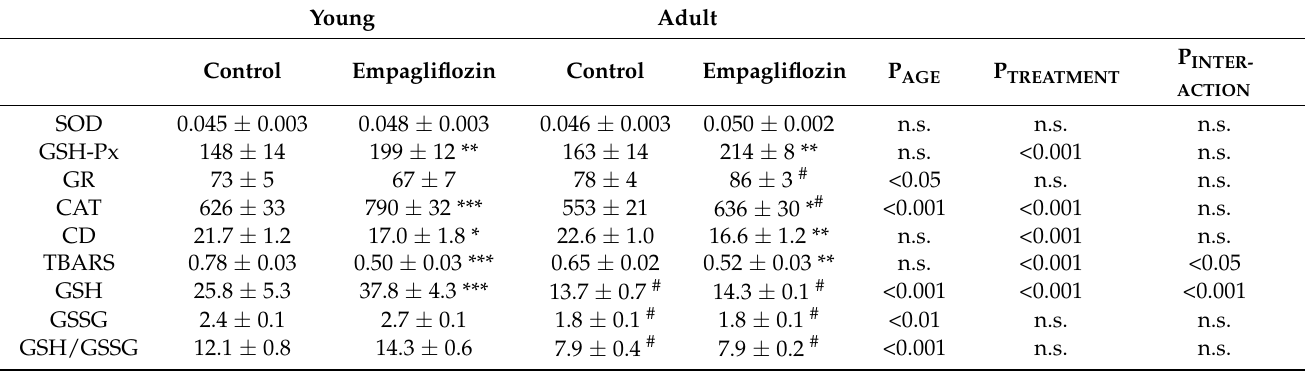
Table 5. Oxidative stress parameters in kidney cortex in experimental groups at the end of the